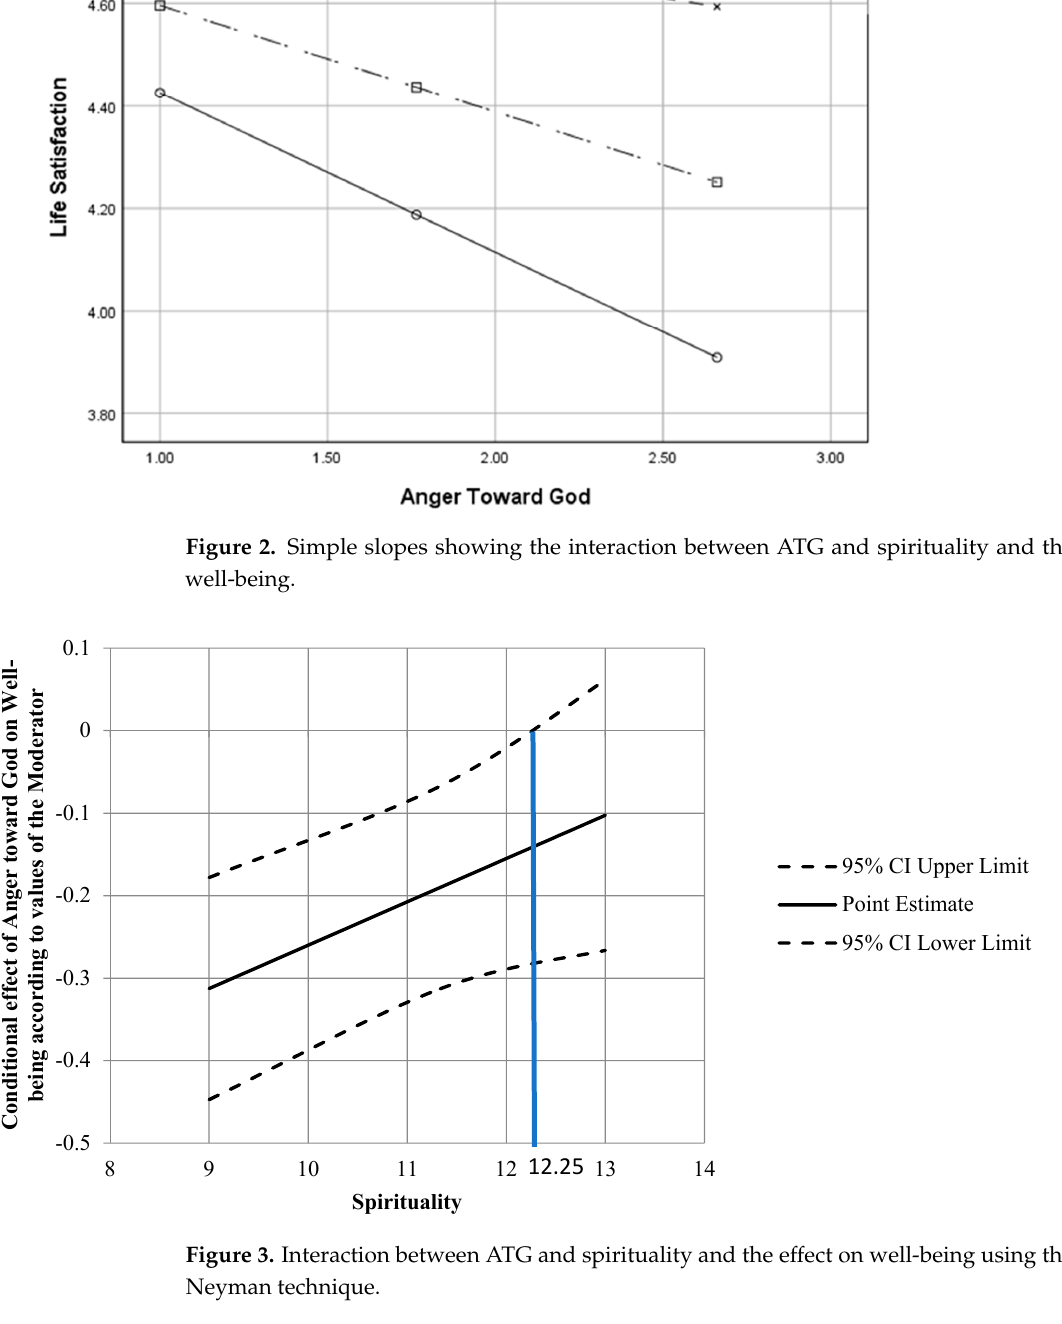
Figure 3. Interaction between ATG and spirituality and the effect on well-being using the Johnson–Neyman technique.